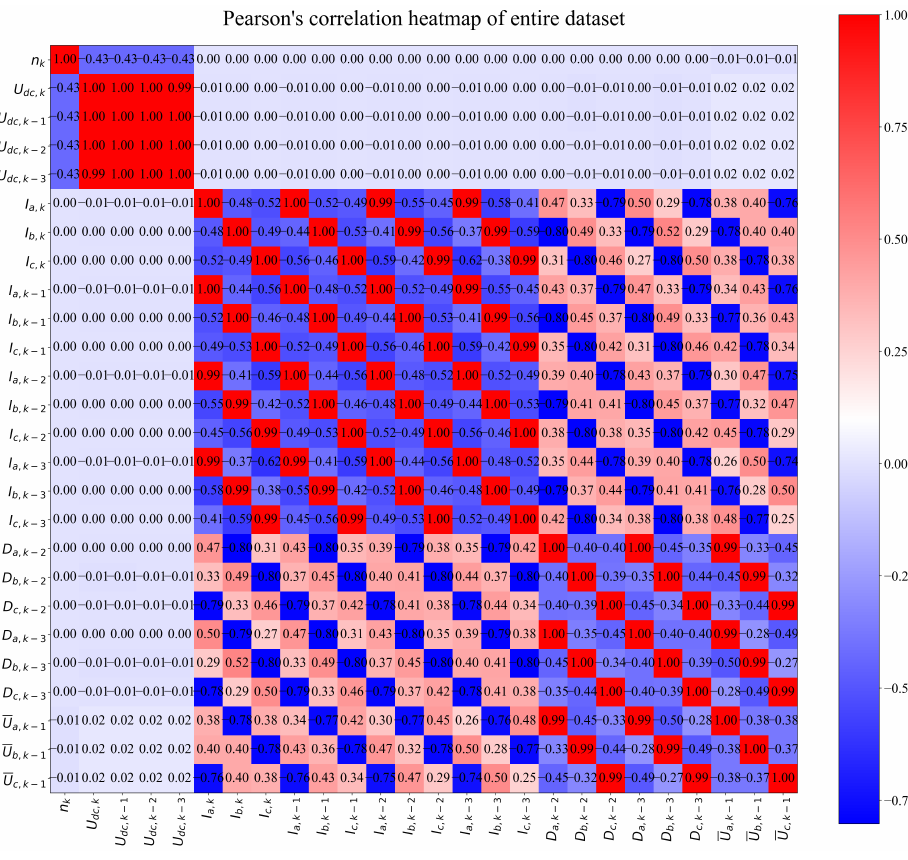
Figure A1. The results of Pearson’s correlation analysis for all dataset variables.